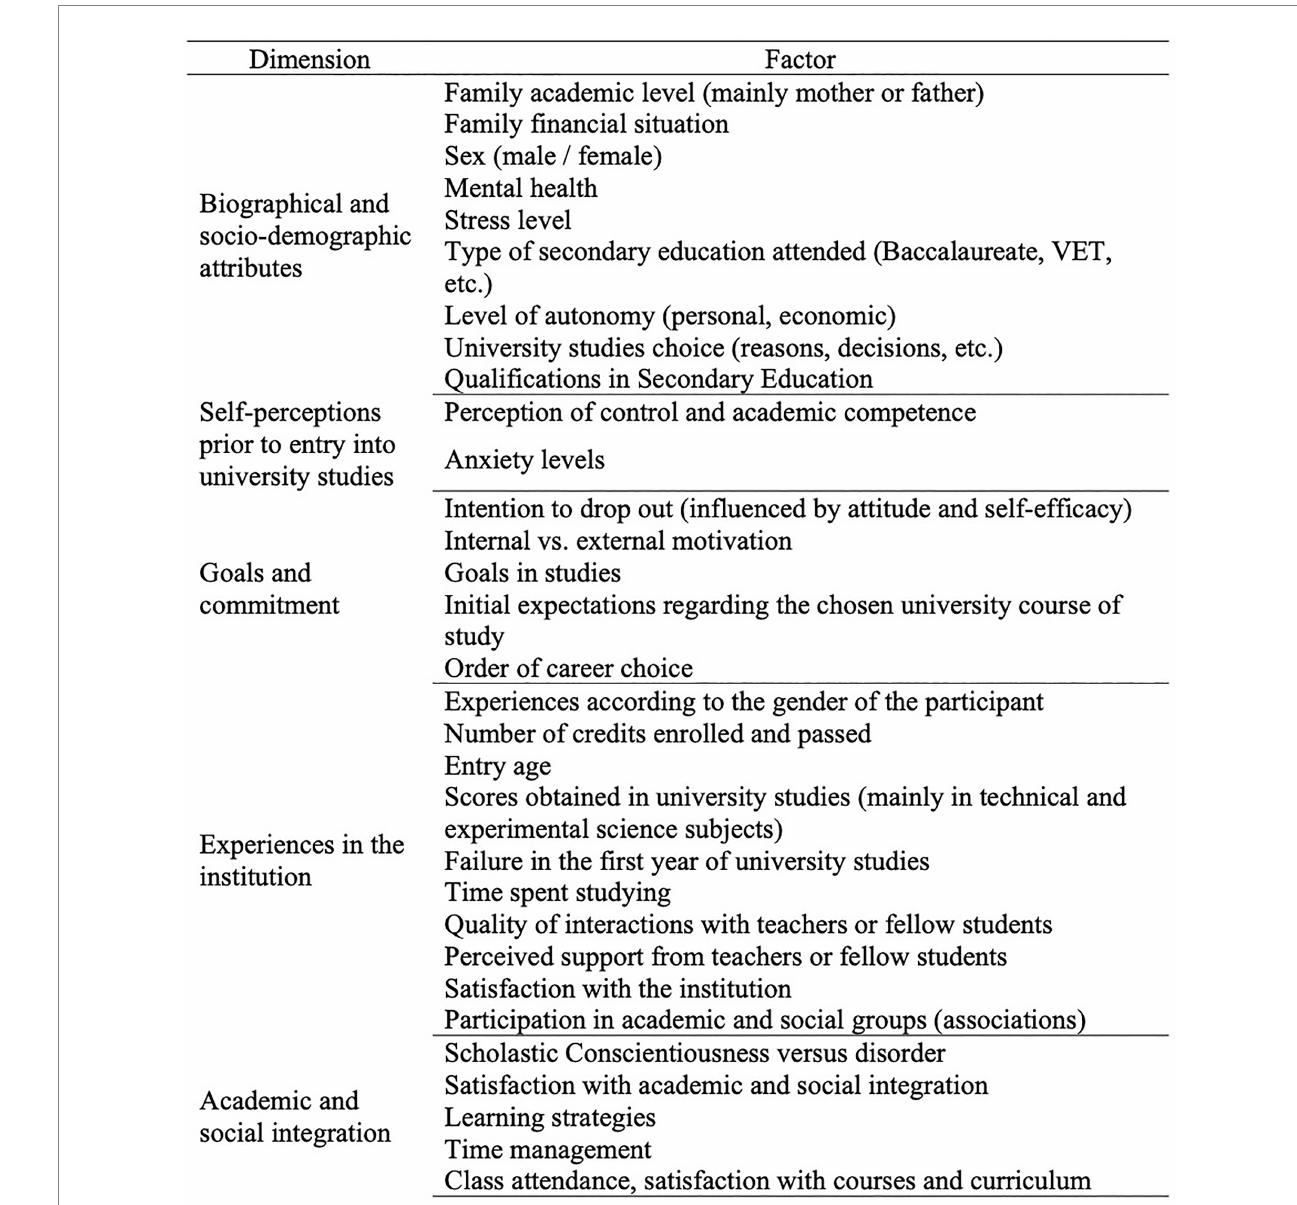
FIGURE 2 Factors related to early dropout and their dimensions. Source from Berlanga (2014), Lizarte (2020), Barroso et al. (2022), and Lizarte Simón and Gijón Puerta